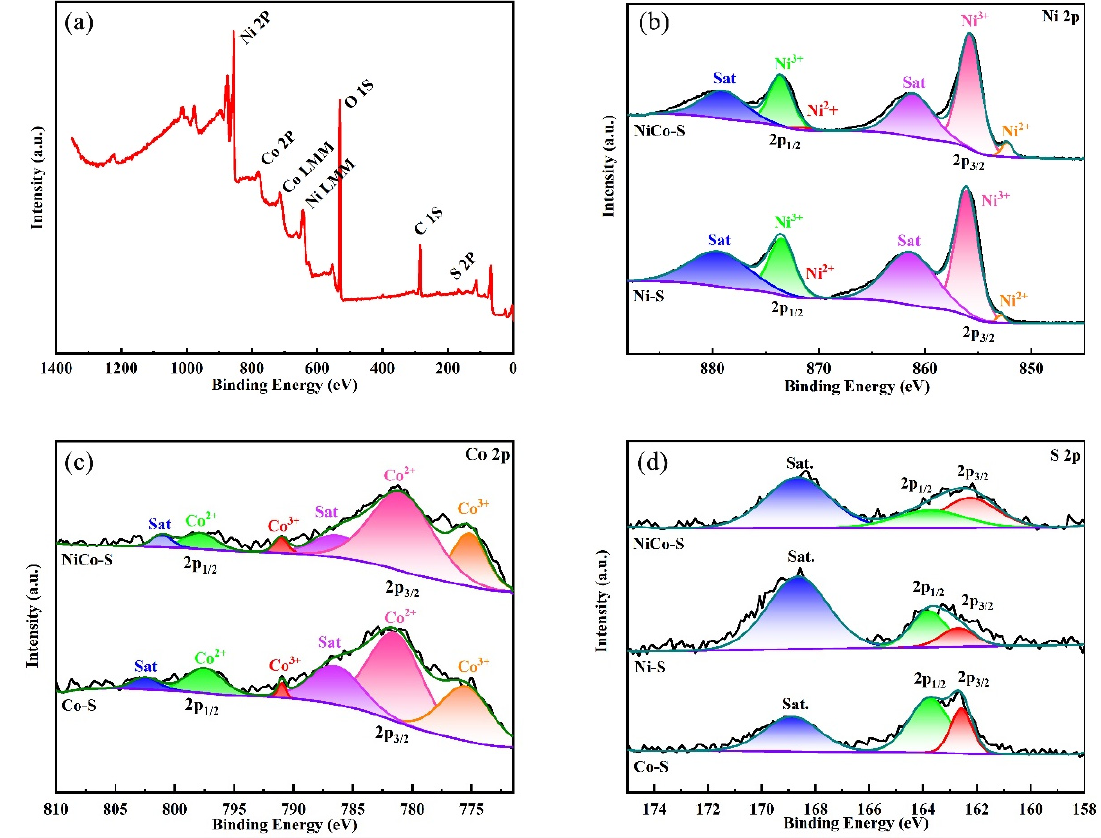
Figure 3. ( a ) XPS survey spectra of NiCo-S/NF electrode, high-resolution XPS spectra of NiCo-S/NF, Ni-S/NF, and Co-S/NF of ( b ) Ni 2p, ( c ) Co 2p, and ( d ) S 2p.